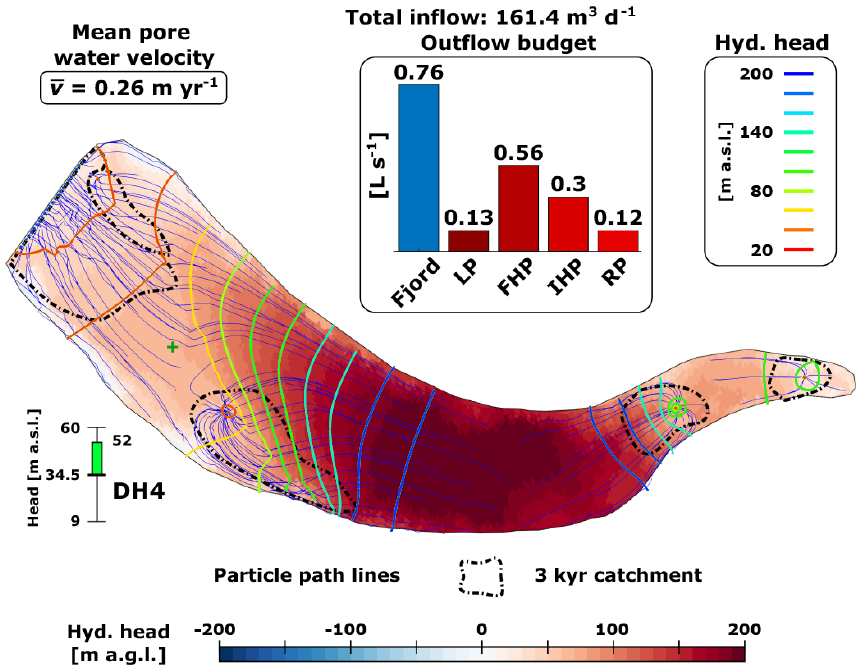
Figure 10. Groundwater model simulation representing additional pressure sources. Recharge is distributed uniformly at a rate of 1mmyr − 1 . This figure uses the same structure and legend as Fig. 8.